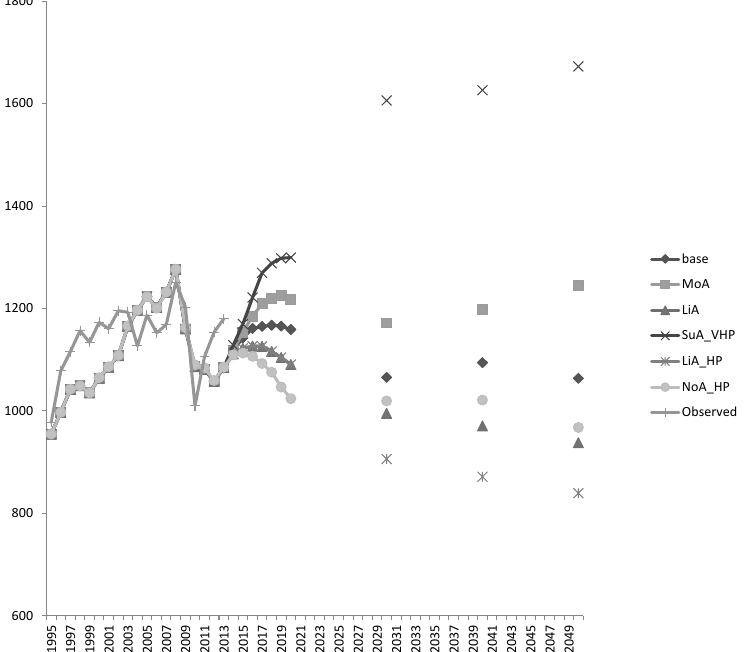
Fig. 4. Land area under cereals (1000 ha). Base = Baseline; MoA = Moderate adaptation (yields +10%); LiA = Little adaptation (yields –10%); SuA_VHP = Succesful adaptation,